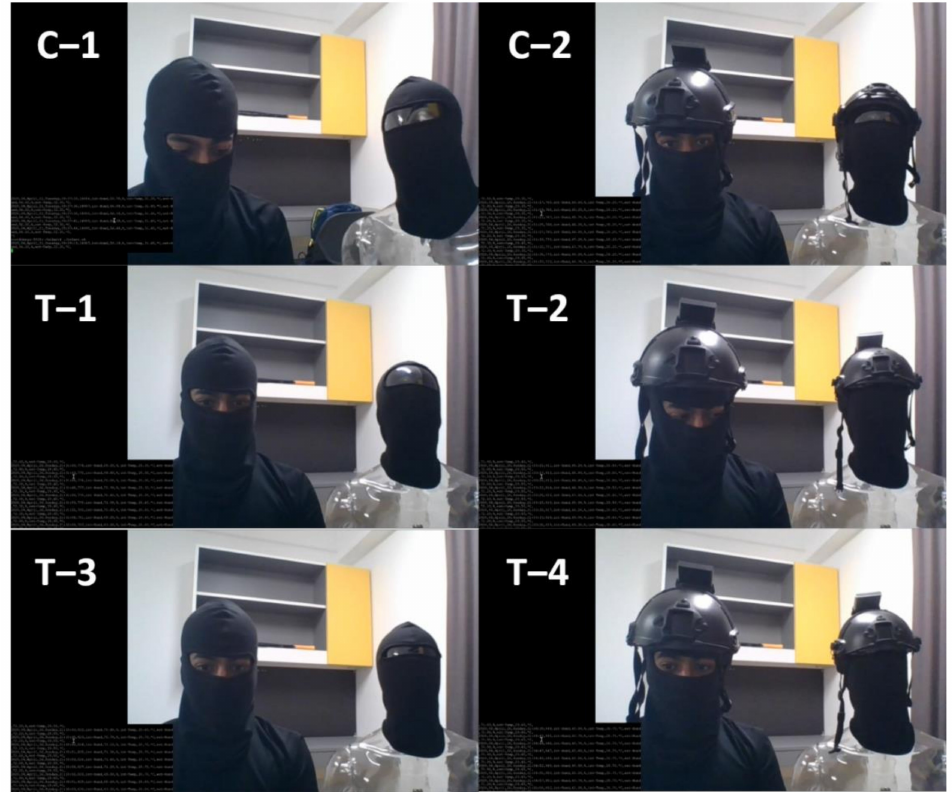
Figure 4. Action sequence of a data-collection run with balaclava mask on human subject and mannequin experiment control. C–1 and C–2 represents NW and W states during calibration phase respectively. T–1 through 4 represents 4 min test